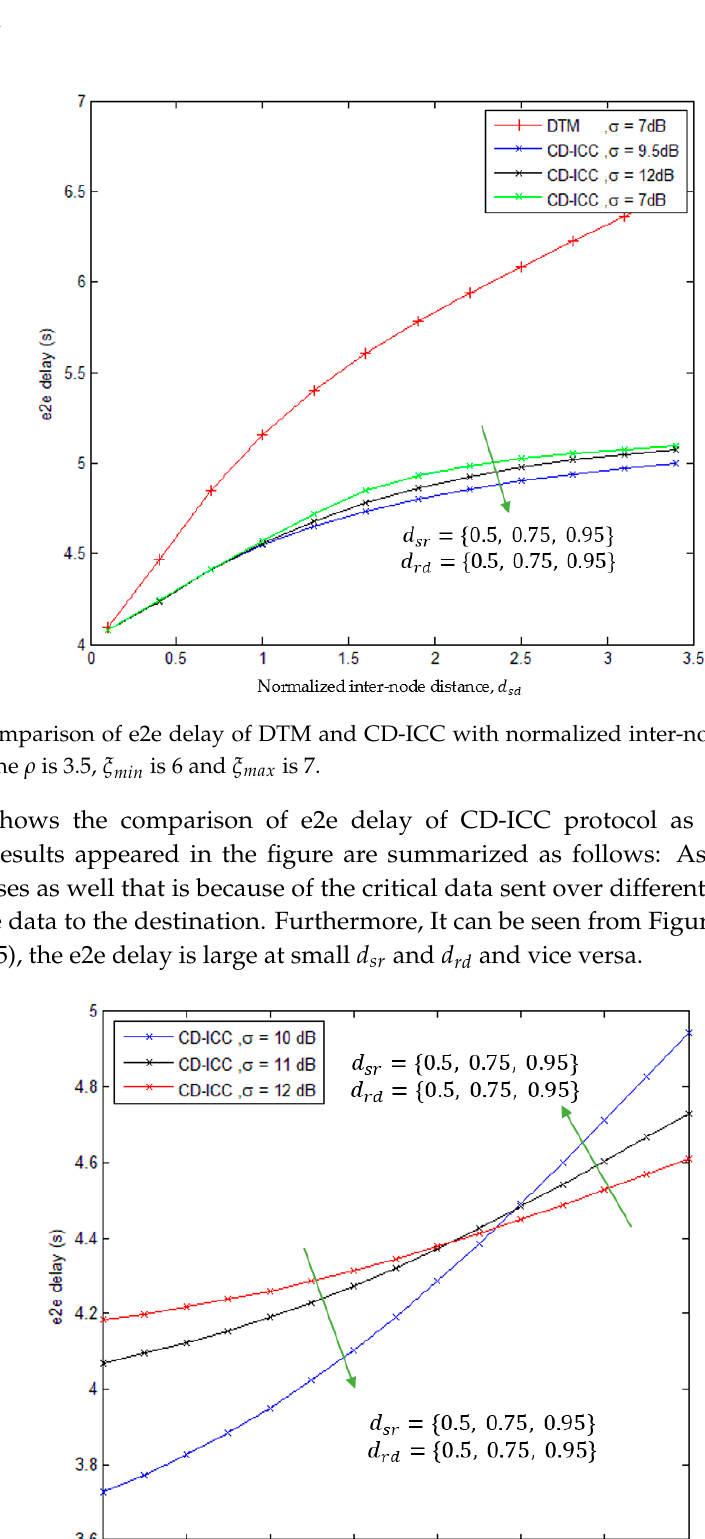
Figure 4. Successful transmission probability of CD-ICC with 𝜉 (cid:3040)(cid:3036)(cid:3041) . In all cases, 𝑑 (cid:3046)(cid:3031) is 1 , and 𝜌 is 3.5.